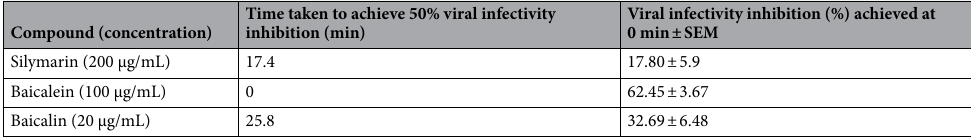
Table 4. The time taken to exert 50% viral infectivity inhibition of flavonoids against DENV-3. Data were acquired from three independent experiments and presented as mean ± standard error mean (SEM).